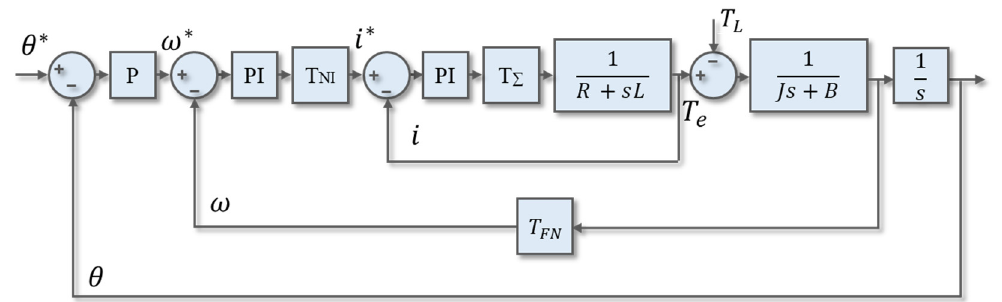
Figure 6. Servo motor control loop with delay time.